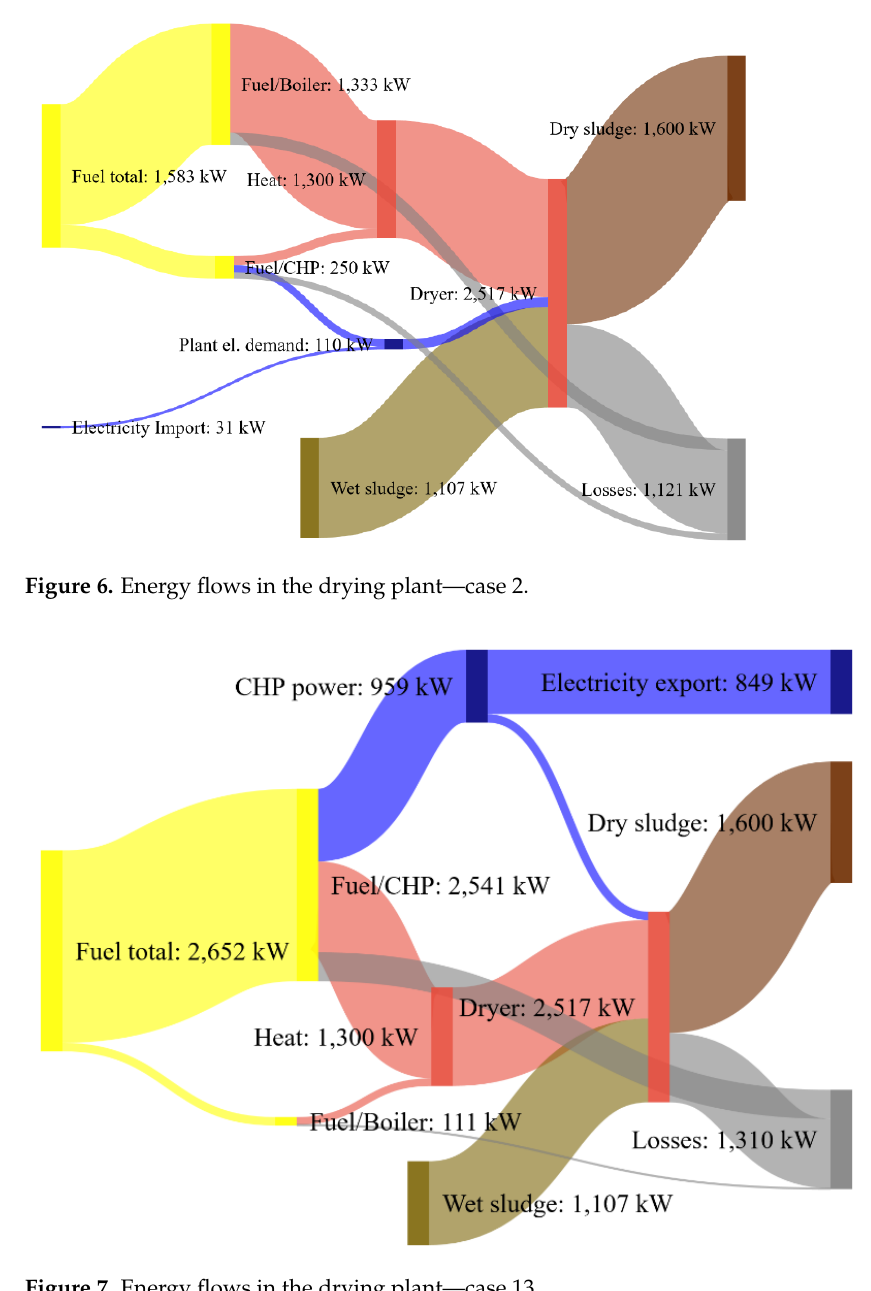
Figure 8. Energy efficiency of the system for the analyzed cases. 4.2. Economic Optimization Optimization analysis has been undertaken for technical and economic assumptions specified in Tables 3 and 4 with the use of the optimization methodology described. For the analyzed project of building a municipal sewage sludge drying plant in an existing